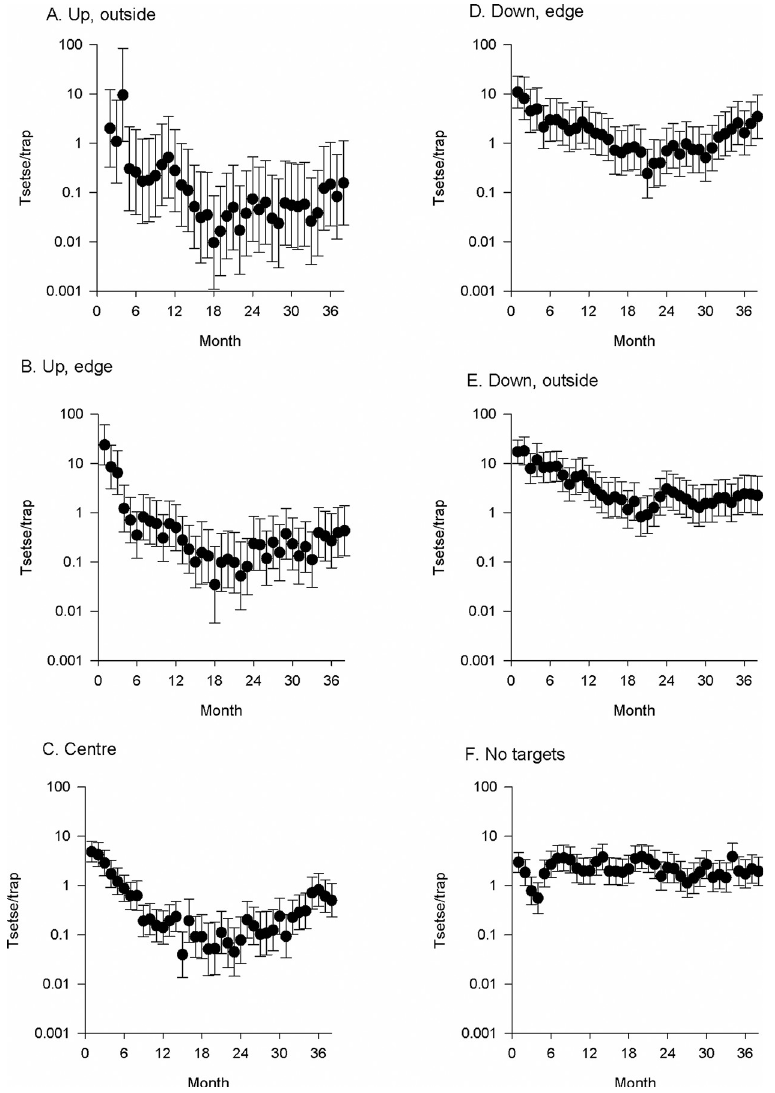
Fig 2. Mean daily catch of tsetse from traps transecting Phase 1 intervention blocks. For each intervention block, pairs of traps were located at sites (A) upstream and outside, (B) on the upstream edge, (C) at the centre, (D) downstream edge and (E) downstream and (F)